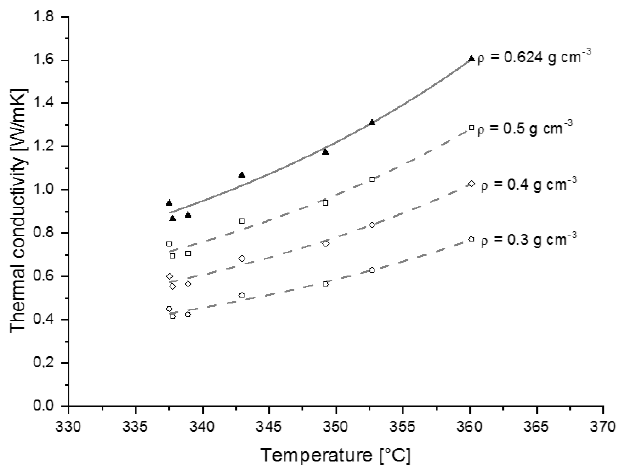
Figure 12. Thermal conductivity measured at different temperature for several densities, calculated under H 2 atmosphere with the in situ measurement technique.